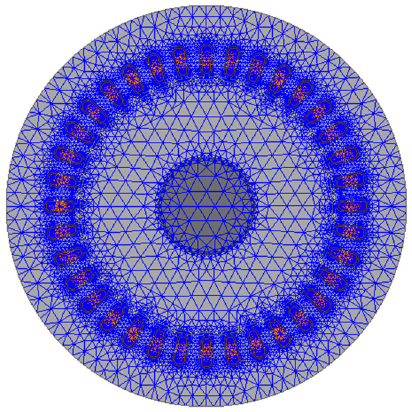
Figure 9. Finite element mesh of the reference field model.